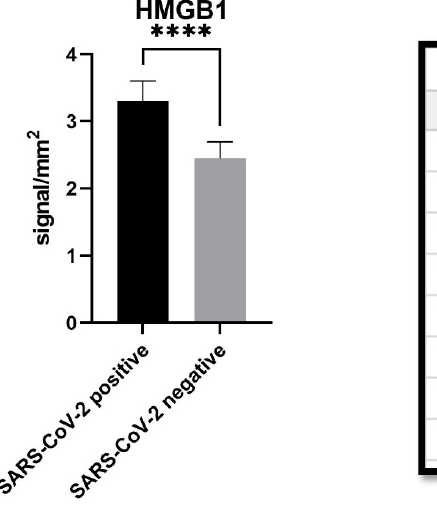
Figure 6. ( A ) TIM-3 immunostaining of SARS-CoV-2 positive patient skin sample by both molecular swab and S1-spike protein immunohistochemistry. Note the presence of predominantly subepithelial T lymphocyte clusters strongly positive